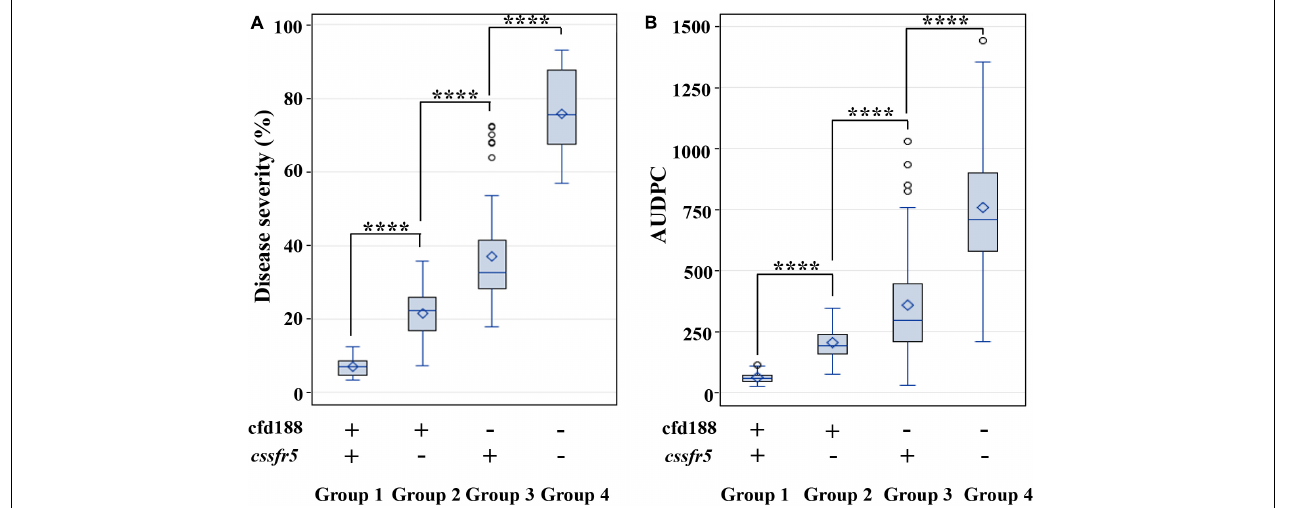
FIGURE 5 | Boxplots showing the effects of the F 2 : 3 family groups on leaf rust severities (or AUDPC) in the RL6058 × BQM cross. Refer to the caption of panel Figure 4 for the F 2 : 3 family grouping. Tests were conducted in 2018 under greenhouse conditions (A) and in the field of Souther Gansu Province (B) . **** indicates significant difference at p < 0.0001 based on Fisher’s least significant difference test. Within each box, the small diamond and the horizontal line indicate the mean and median area under the disease progress curve (AUDPC), respectively. The top and bottom edges of a box illustrate the 75th and 25th percentiles, respectively. Whiskers (vertical lines outside a box) extend to the extreme data points, and small circles denote outliers.